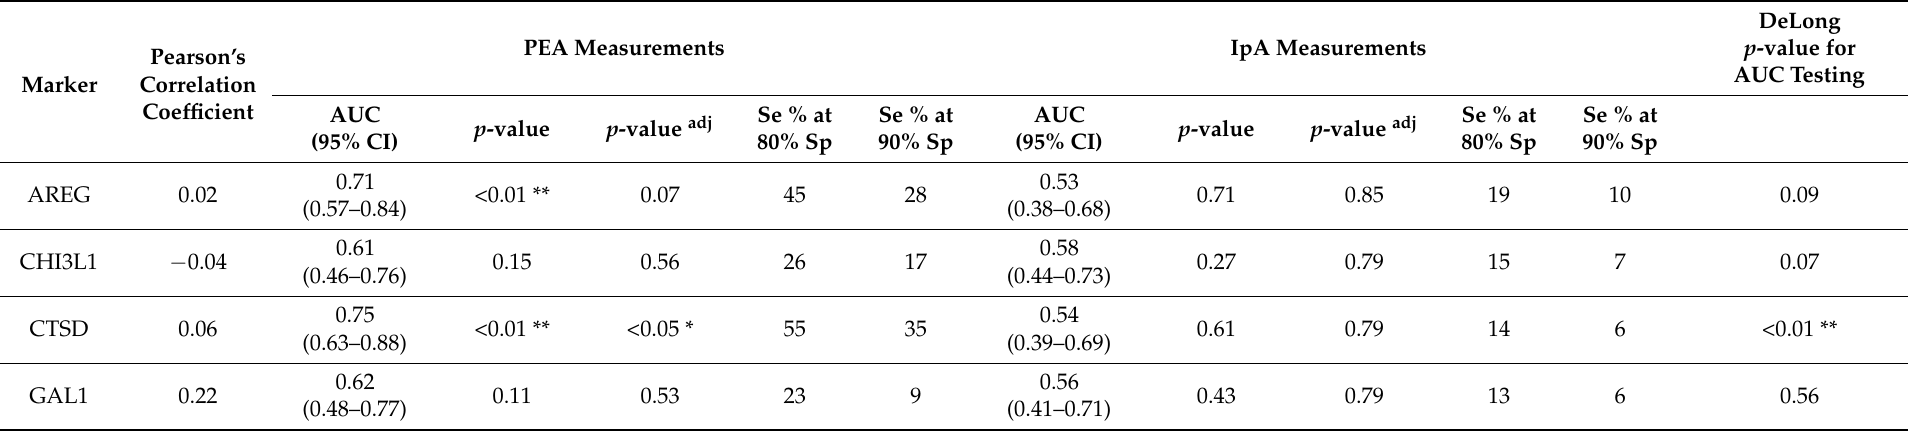
Table 4. Diagnostic performance for 11 out of 35 biomarkers overlapping from PEA and IpA measurements for detecting CRC cases from participants in screening